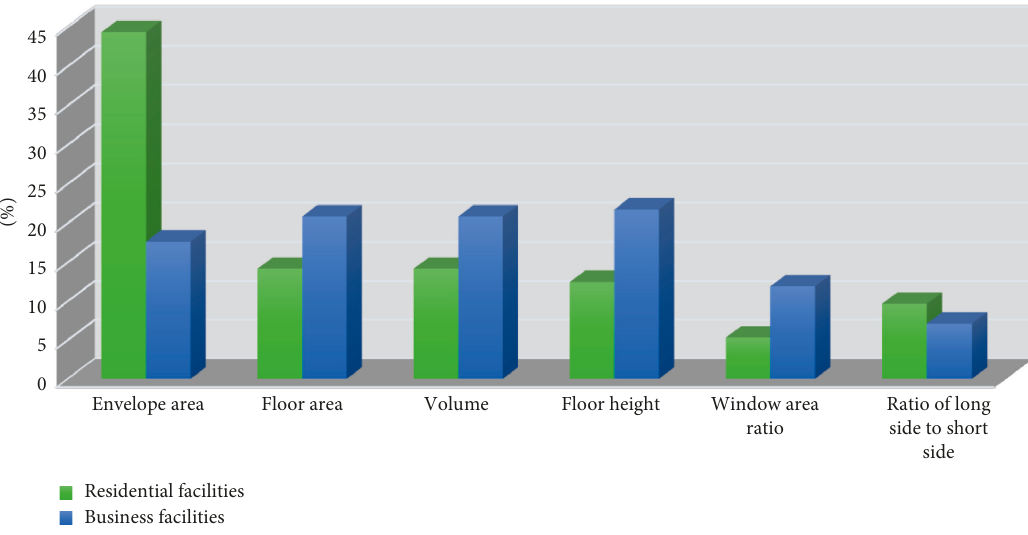
Figure 14: Rate of transformation influenced by hierarchy by architectural design elements